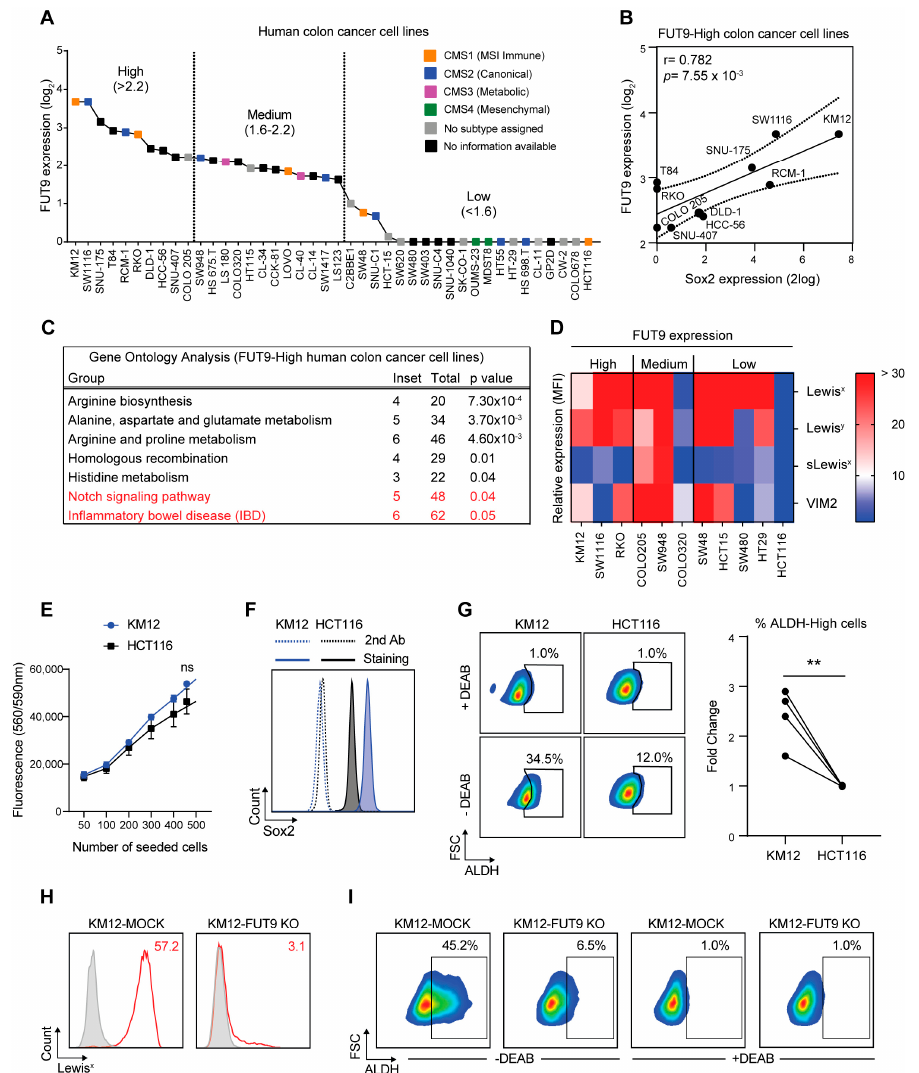
Figure 4. FUT9 expression in human colon cancer cell lines is correlated with high levels of Sox2 expression and ALDH activity. ( A ) Classification of human colon cancer cell lines based on FUT9 gene expression levels. Data were obtained from the Cancer Cell Line Encyclopedia (CCLE) database. The corresponding molecular subtype for each cell line (if known) is provided [50]. ( B ) Correlation between FUT9 and Sox2 gene expression in the subgroup of FUT9-High human colon cancer cell lines. ( C ) Gene Ontology Analysis in FUT9-High human colon cancer cells depicting all the statistically significant ( p < 0.05) groups. ( D ) Relative surface expression (MFI) of type II Lewis antigens (Lewis x , Lewis y , sialyl Lewis x and VIM2) on the surface of selected FUT9-High/Medium/Low human colon cancer cell lines, measured by flow cytometry. MFI values were normalized to the binding of the secondary antibody alone. ( E ) Cell proliferation of KM12 and HCT116 cells cultured in 2D at different absolute numbers as determined by the CTB fluorometric assay. Error bars represent SD; n = 3. Statistical differences were determined by an unpaired Student’s t test (ns; no significance). ( F ) Flow cytometric analysis of intracellular Sox2 expression in KM12 and HCT116 cells cultured in 2D. Dotted lines represent staining with the secondary antibody alone, whereas solid lines represent Sox2